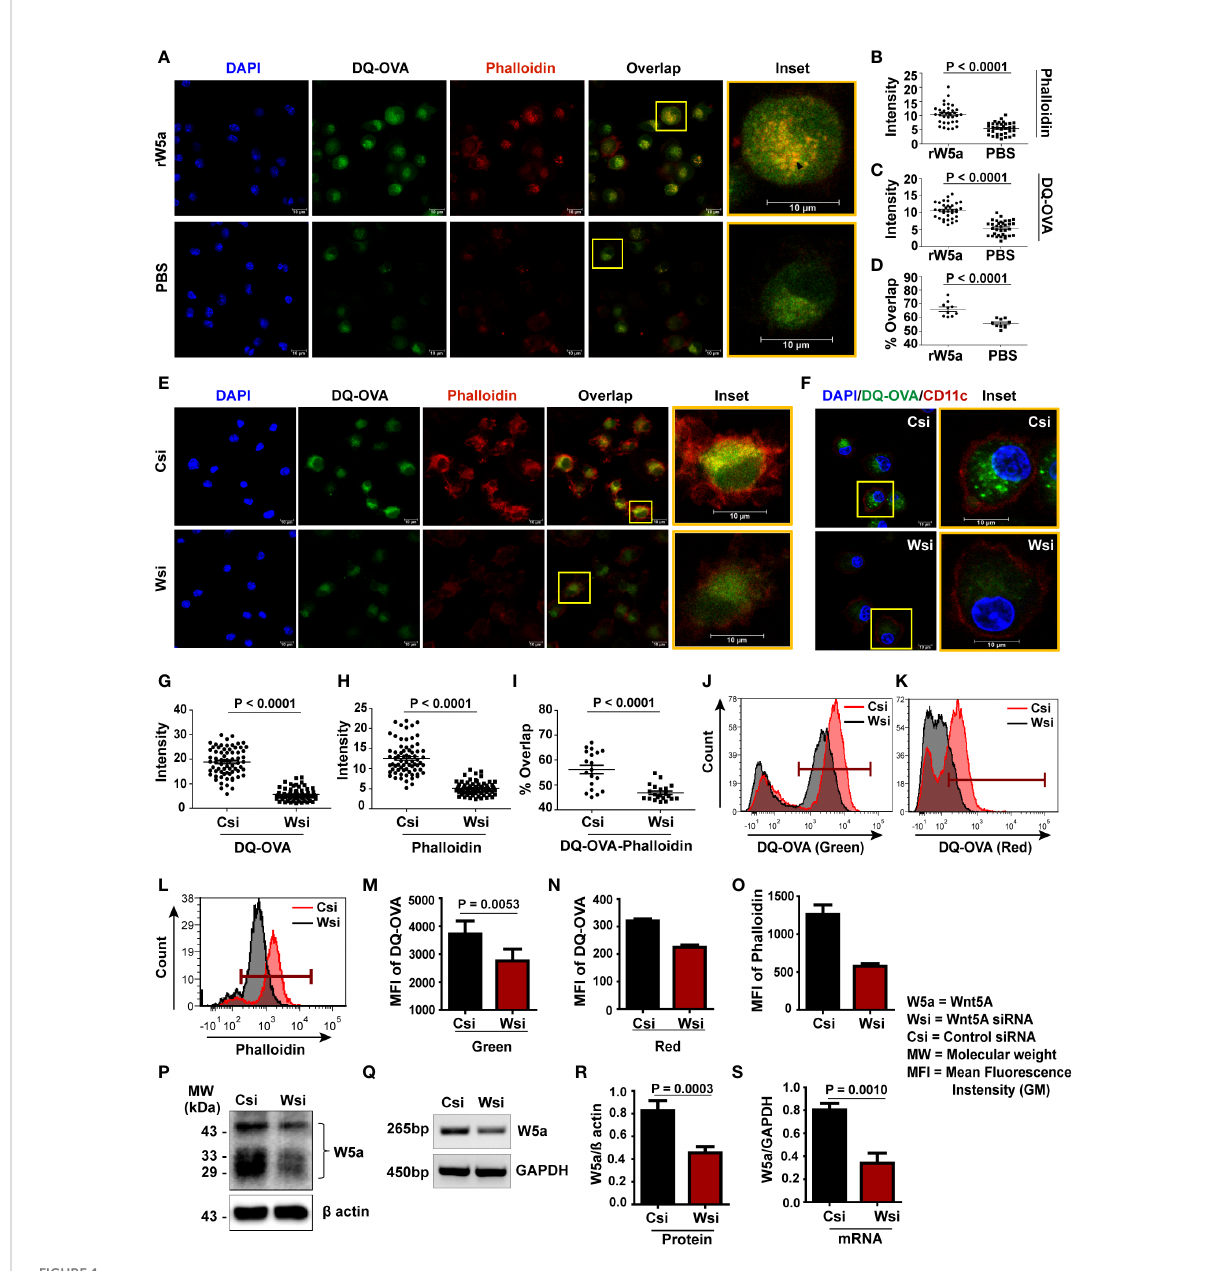
FIGURE 1 Wnt5A promotes DQ-OVA processing in BMDC: (A – D) rWnt5A mediated increase in phalloidin-red intensity (A, B) , DQ-OVA-green intensity (A , C) , and DQ-OVA-phalloidin overlap intensity (A , D) in comparison to vehicle control (PBS), as demonstrated by confocal microscopy of conditioned (rWnt5A treated) BMDC, and subsequent ImageJ analysis (intensity measurement) and Mander ’ s overlap coef fi cient analysis of different microscopic fi elds. Merge/overlap of DQ-OVA and phalloidin is emphasized in insets. The nucleus is denoted by the DAPI stain. (E, G – I) : Similar representations demonstrating correlative decreases in DQ-OVA intensity, phalloidin intensity, and DQ-OVA-phalloidin overlap intensity in Wsi (siRNA transfected BMDC) compared to Csi (control siRNA transfected BMDC). The BMDC marker CD11c expression in OVA processing BMDC is demonstrated in F, J-O : Representation of fl ow cytometry (J-L) and MFI (Geometric Mean Fluorescence Intensity) plot (M-O) on CD11c gated cells demonstrating a decrease in DQ-OVA and phalloidin fl uorescence in Wnt5A depleted BMDC (Wsi) as compared to control (Csi). About 50% depletion of Wnt5A by transfection was detected at both protein and mRNA levels ( P, Q respectively, cropped from raw data, as explained in S3) and by corresponding densitometry (R, S) . For intensity measurement related to confocal microscopy (B, C, G, H) , each dot represents a cell from two independent experiments (n = 2, ~14 fi elds). For Mander ’ s overlap coef fi cient analysis ( D, I : n = 2, 10 fi elds), each dot represents a fi eld from two independent experiments. Magni fi cation: 63X (2X zoom). The arrow mark (black) shows overlap (yellow spots). For fl ow cytometry (n = 2 - 5) marker gate for DQ-OVA was selected based on an unstained cell histogram. The bar represents mean ± SEM (Standard error of the mean) with exact p values depicted in the fi gure. n represents the number of individual experiments. For (B – D, G – I) Student ’ s unpaired t-test was performed and for J – O and R , S Student ’ s paired t-test was